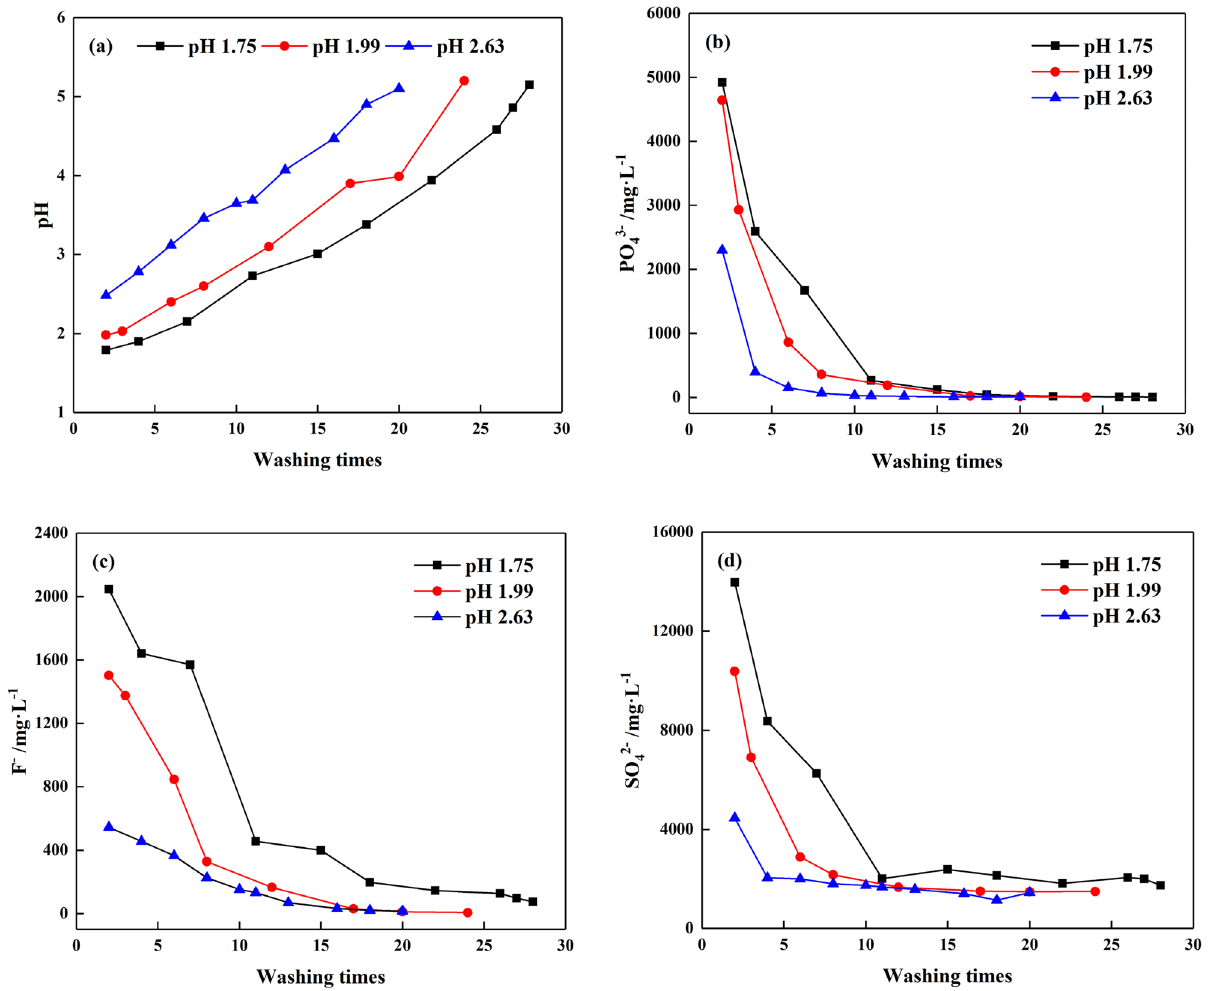
Figure 5. Variations of pretreated PG with different initial pH value: ( a ) pH, ( b ) PO 4 3− , ( c ) F − , ( d ) SO 4 2−